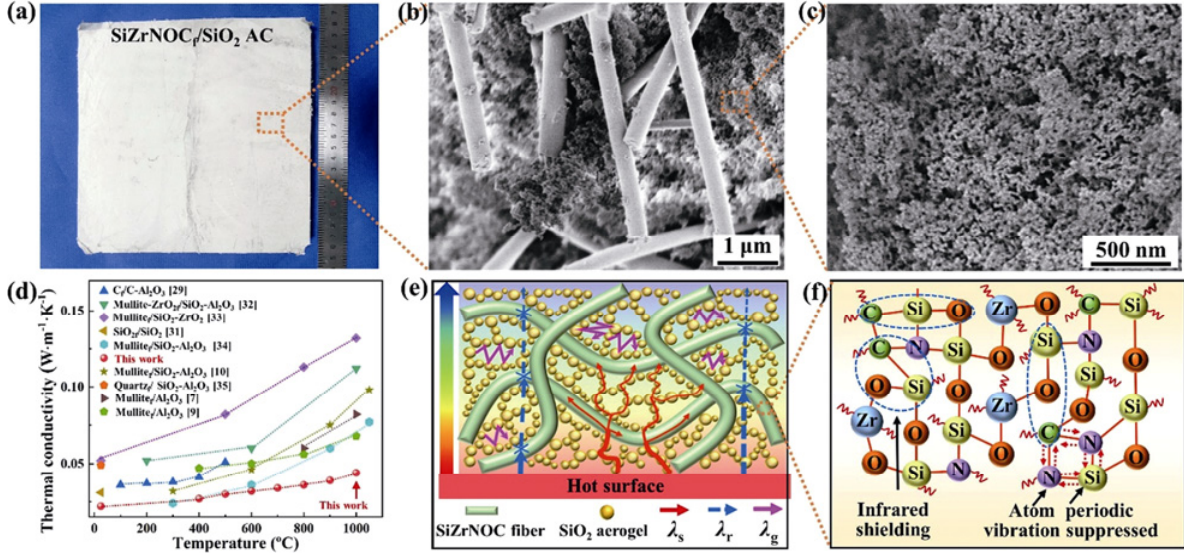
Fig. 7 (a) Photograph and (b, c) SEM images of the SiZrNOC f /SiO 2 ACs, (d) comparison of λ among different ceramic fiber-reinforced ceramic aerogels, and (e, f) schematic illustration of the thermal insulation